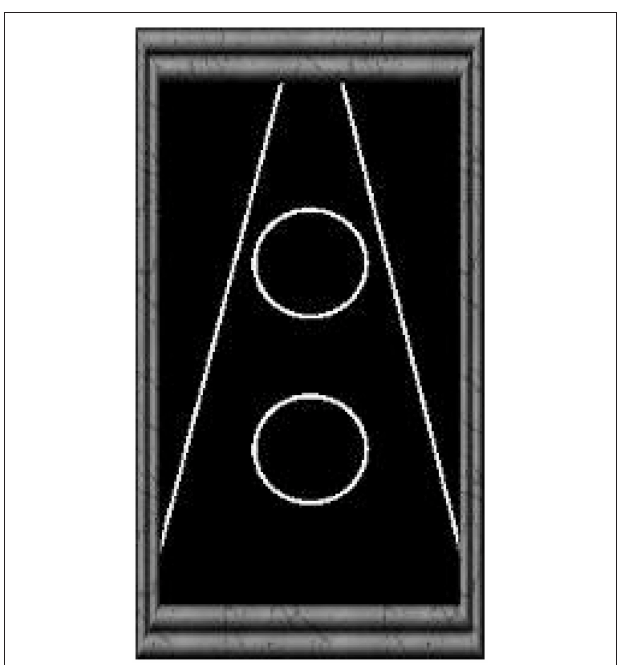
FIGURE 10 | Ambiguity Figure